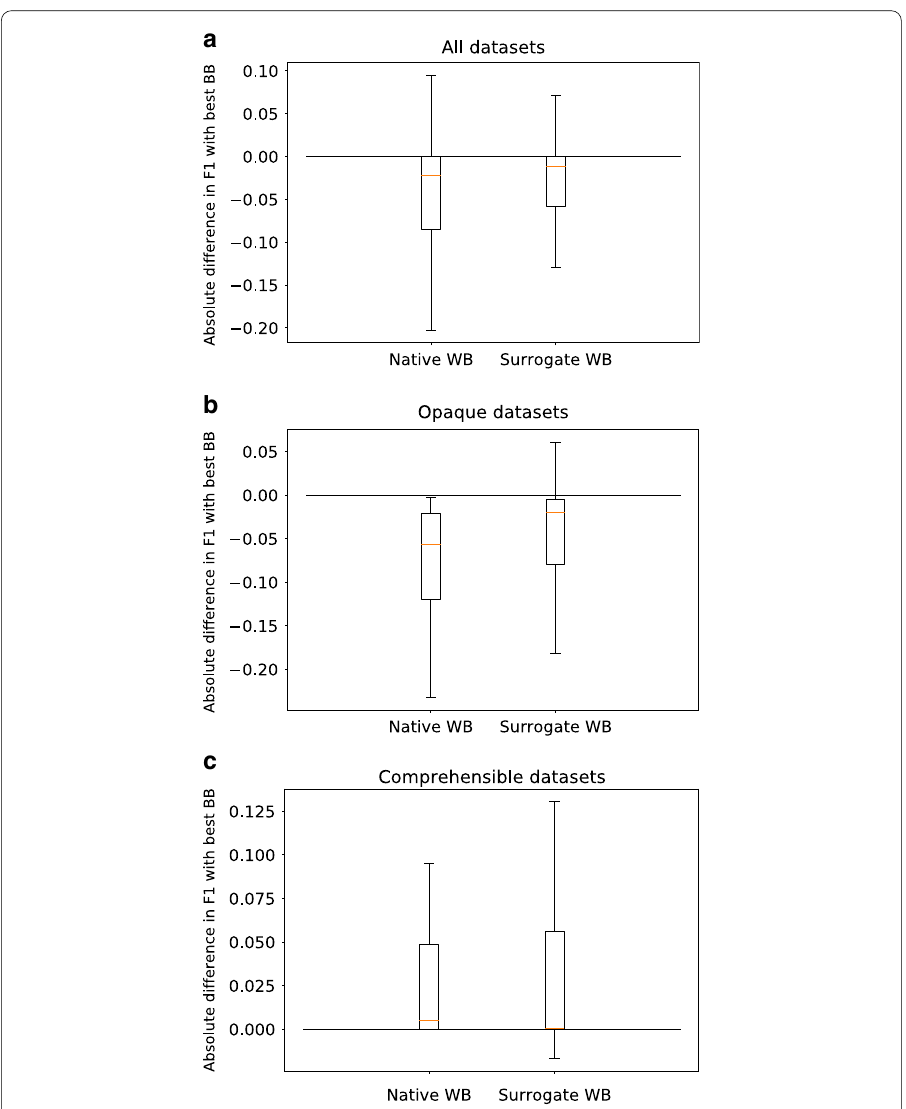
Fig. 5 Comparison across datasets of best black box model for each dataset, surrogate white box model mimicking this best black box, and best native white box model. BB stands for black box and WB for white box. The line at 0 indicates the performance of the best black box model. The y-axis indicates the absolute difference in f1-score from the best black box model